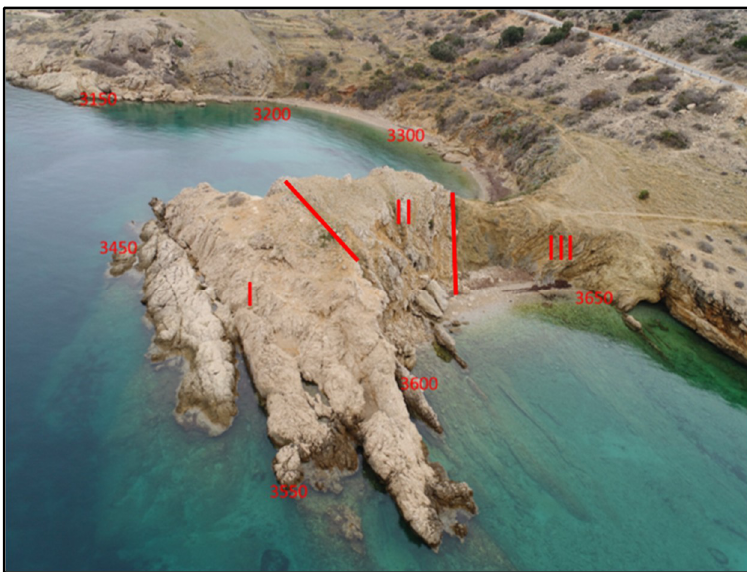
Figure 10. View of the northwestern part of the research area: I, fissured limestone rock mass; II, crushed limestone rock mass; III, flysch rock mass.